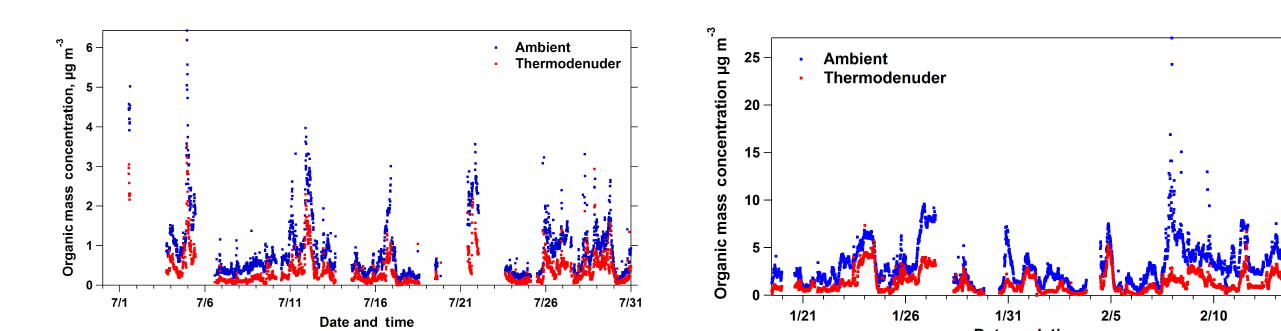
Figure 2. Ambient (blue dots) and thermodenuder (red dots) OA mass concentration time series for the winter 2010